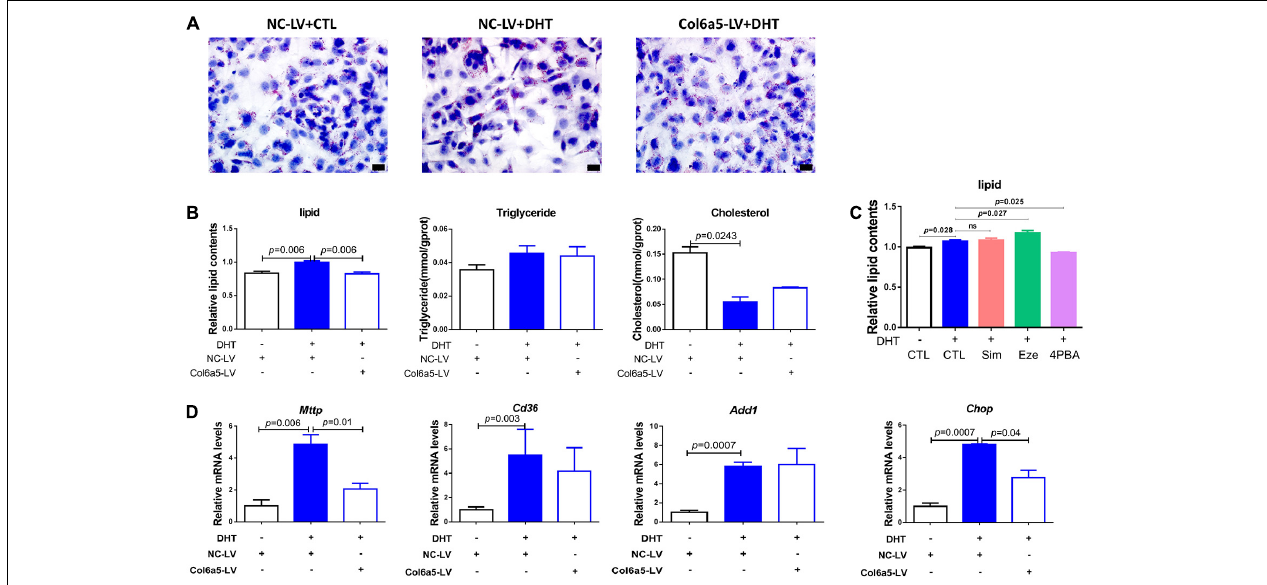
FIGURE 5 | Col6a5 -LV alleviated excess lipid accumulation in DHT-treated adipogenic 3T3-L1 cells. (A) Oil Red O staining of differentiated 3T3-L1 cells; n = 3; scale bars = 20 µ m; NC-LV, negative control lentivirus; Col6a5 -LV, LV- Col6a5 -CRISPR/Cas9 recombinant lentivirus. Cells were cultured in adipogenic differentiation cocktail media with 1 µ M DHT. Lentivirus transfection was completed before DHT treatment. (B) Quantification of lipid, TG and TC levels in differentiated 3T3-L1 cells; n = 3. The data are expressed as the mean ± SEM and were compared by Mann-Whitney U -test. (C) Process-specific inhibition of cholesterol metabolism and relative quantification of lipid concentration in differentiated 3T3-L1 cells from each treatment group; n = 3. The data are expressed as the mean ± SEM and were compared by Mann-Whitney U -test. (D) Relative expression of lipid metabolism-related genes in differentiated 3T3-L1 cells from each treatment group; n = 3. The data are expressed as the mean ± SEM and were compared by Mann-Whitney U